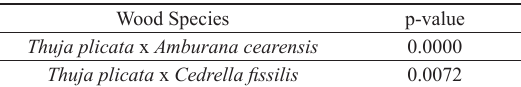
Table 9. Relation between ashes